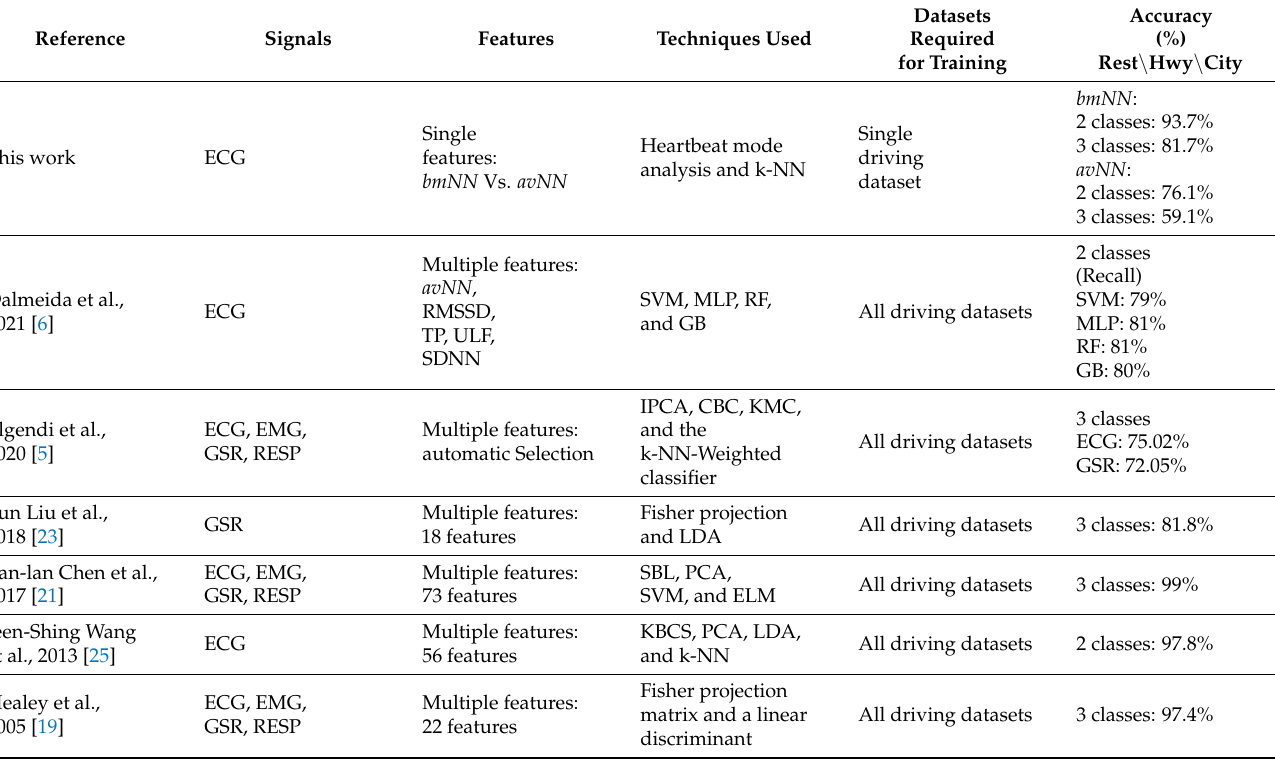
Table 5. Comparison of this and related works for stress detection using the drivedb